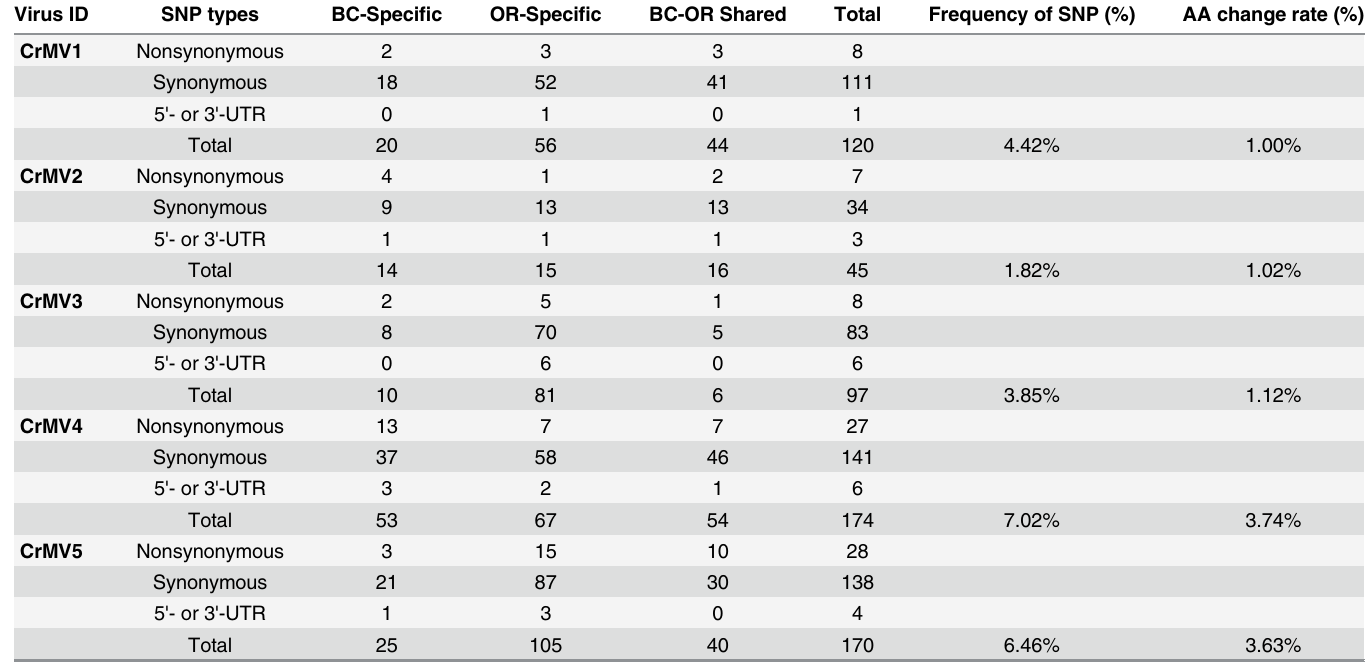
Table 3. Genomic variations of Cronartium ribicola mitoviruses (CrMVs) in BC and OR regions.